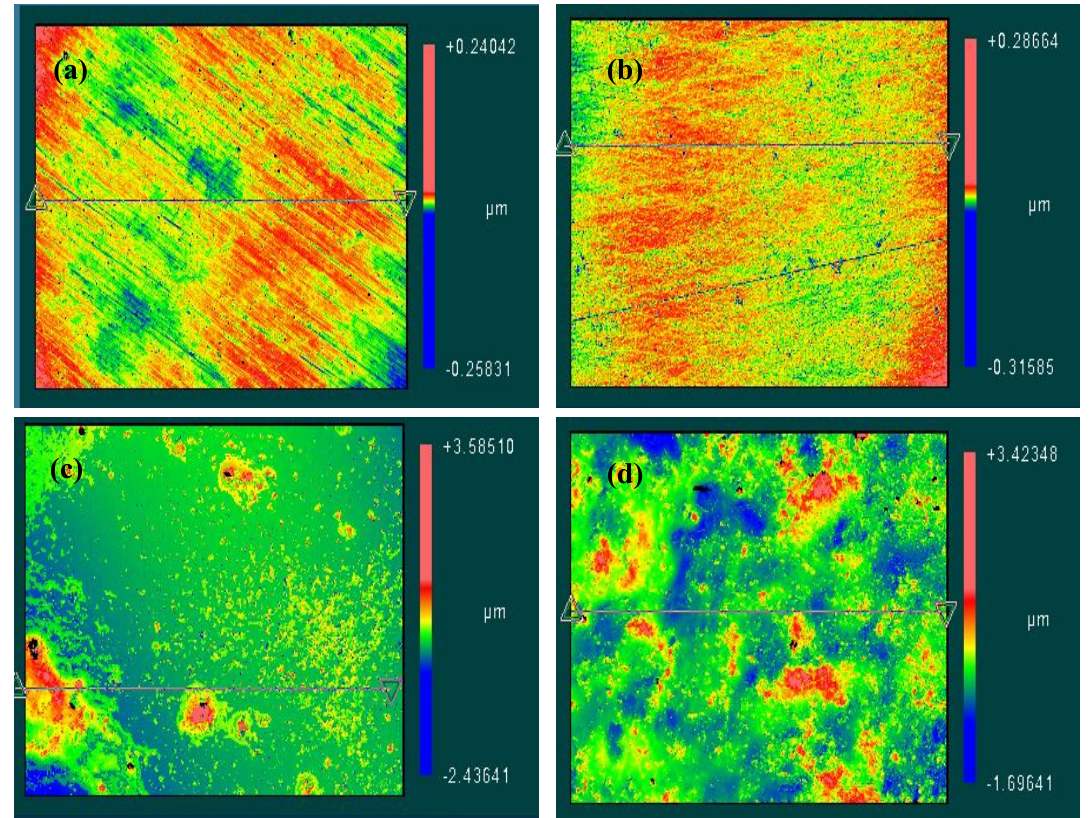
Figure 9. Optical surface profiler images for selected 316L stainless steel samples after corrosion testing in ( a ) 0.1 wt.% CNTs nanofluid at 60 °C ( b ) 0.1 wt.% CNTs nanofluid at 80 °C ( c ) 1.0 wt.% CNTs nanofluid at 60 °C ( d ) 1.0 wt.% CNTs nanofluid at 80 °C.